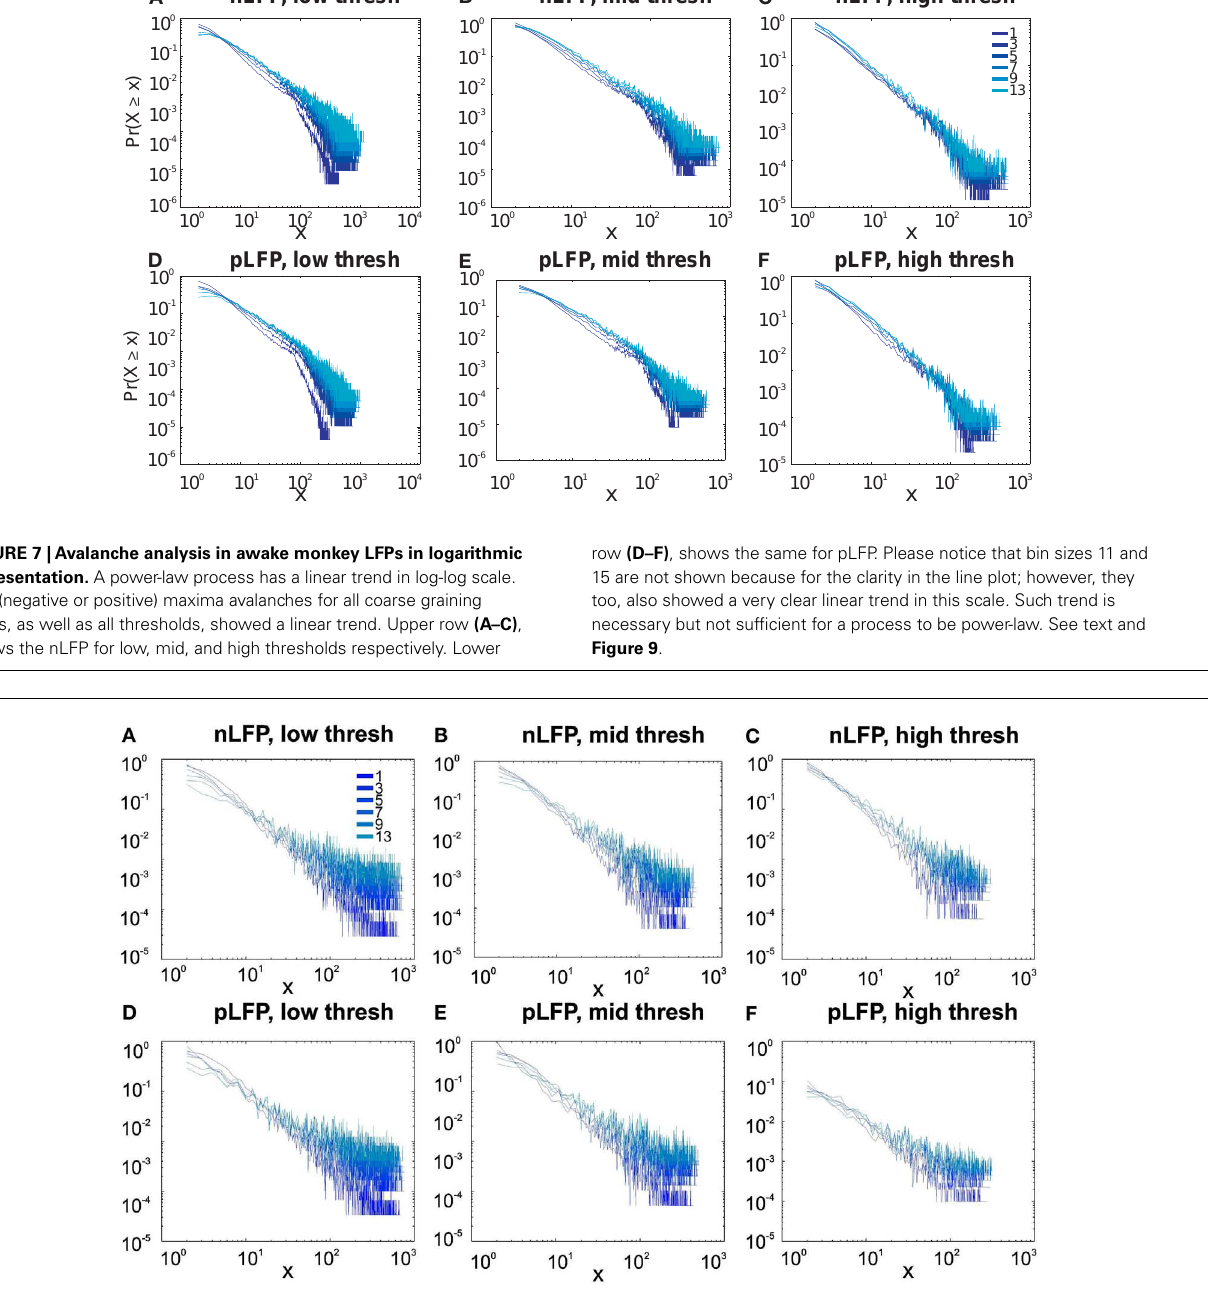
FIGURE 8 |Avalanche analysis in awake human LFP in logarithmic representation. A power-law process has a linear trend in log-log scale. LFP (negative or positive) maxima avalanches for all coarse graining levels, as well as all thresholds, showed a linear trend. Upper row (A–C) , shows the nLFP for low, mid, and high thresholds respectively. Lower